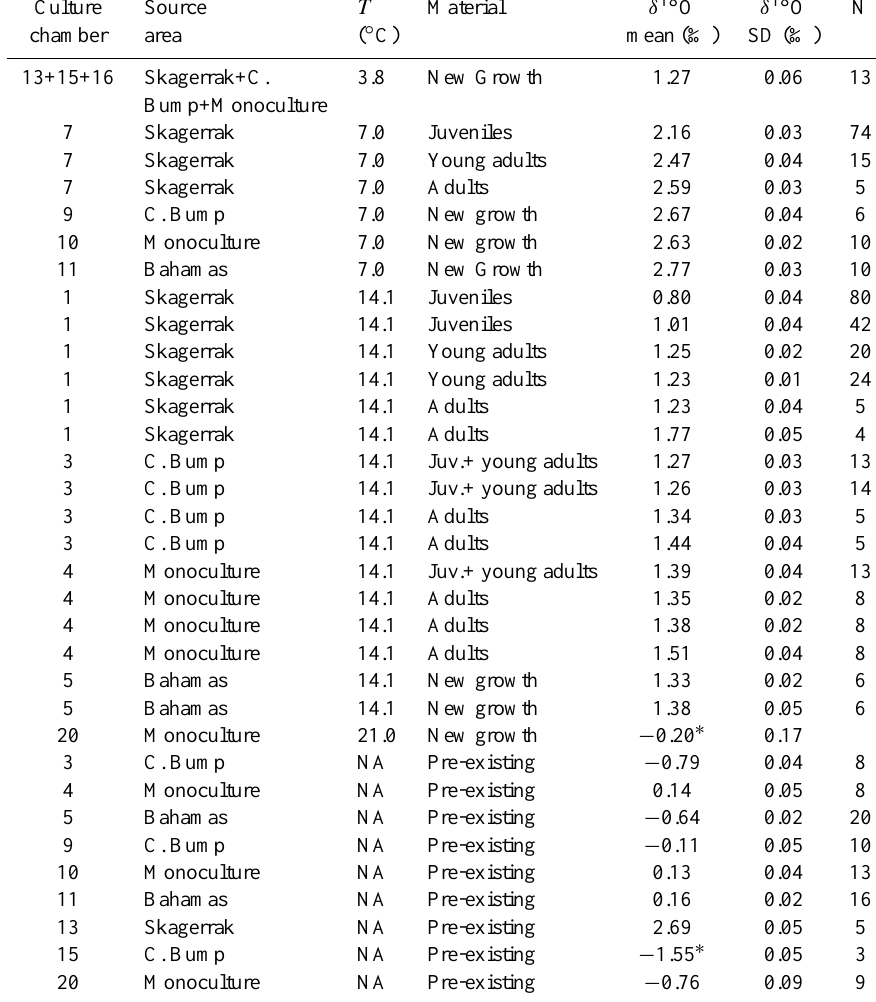
Table 4. Stable oxygen isotopic data for the cultured foraminifera presented for each temperature and size class, together with isotope data for pre-existing calcite. The standard deviations refer the analytical precision of the mass spectrometer. “Monoculture” refers to monocultures of Bulimina aculeata/marginata , originating from the Charleston Bump and near the Great Bahama Bank. N refers to number of specimens or microdissected parts of specimens analyzed. ∗ = small samples with lower analytical